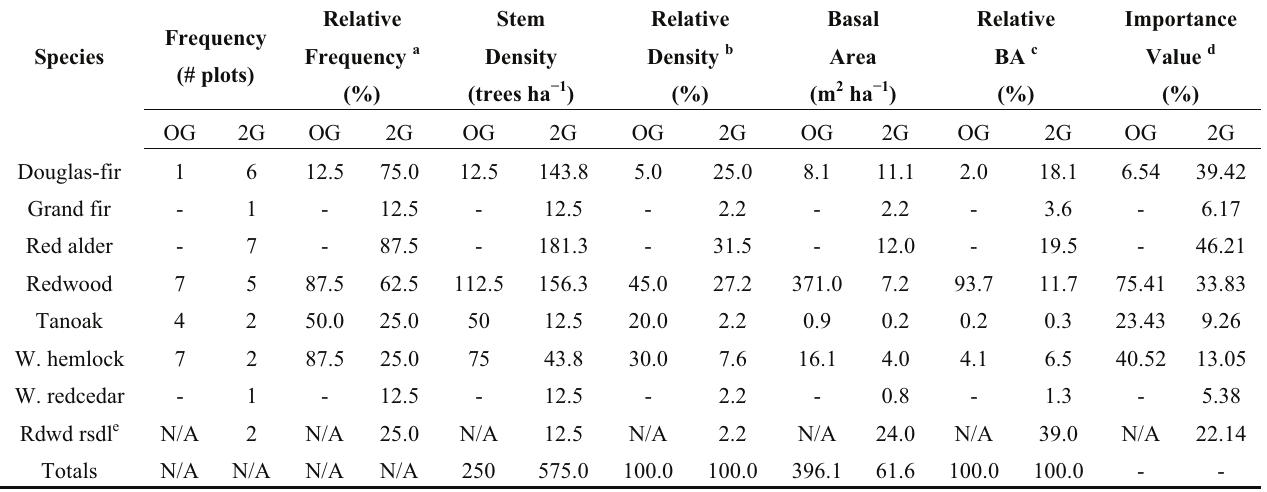
Table 1. Structural attributes of adjacent old-growth and second-growth riparian forests in Little Lost Man and Lost Man Creeks, Redwood National Park,